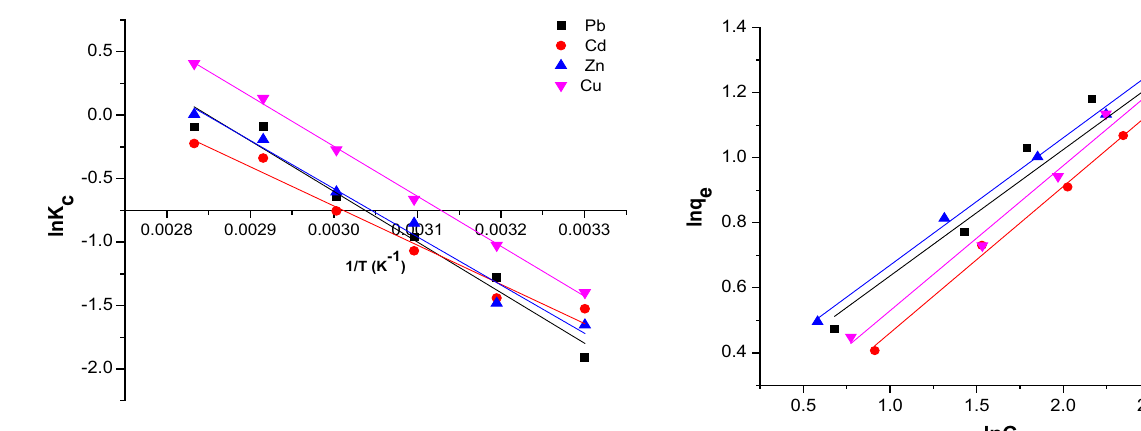
Fig. 10 van’t Hoff plots for the adsorption of Pb, Cd, Zn and Cu ions